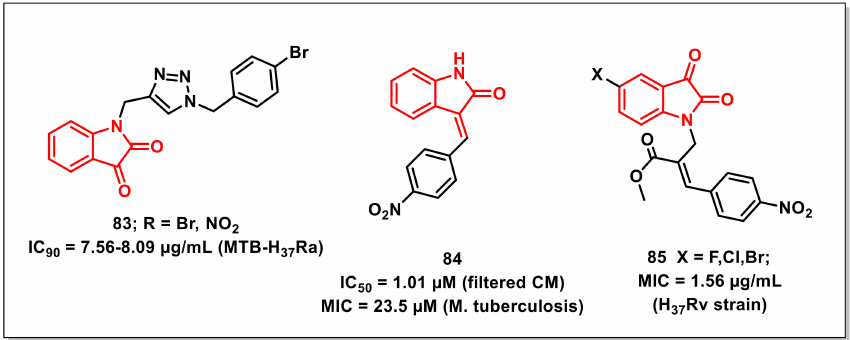
Figure 13. Miscellaneous examples of isatin-based scaffolds as antimycobacterials. Jean kumar et al. demonstrated the utilization of structure-based e-pharmacophore modelling to recognize the small molecule inhibitors of the Mtb chorismite mutase (CM) enzyme. Some isatin subsidiaries were synthesized and assessed in vitro for their ability to re- strain MTB CM and activity against M. tuberculosis . Compound 3-(4-nitrobenzylidene)indolin- 2-one, or 84 , proved to be the most promising and noncytotoxic among the synthesized hybrids, exhibiting an IC 50 of 1.01 µ M for filtered CM and an MIC of 23.5 µ M on M. tuberculosis (Figure 13)